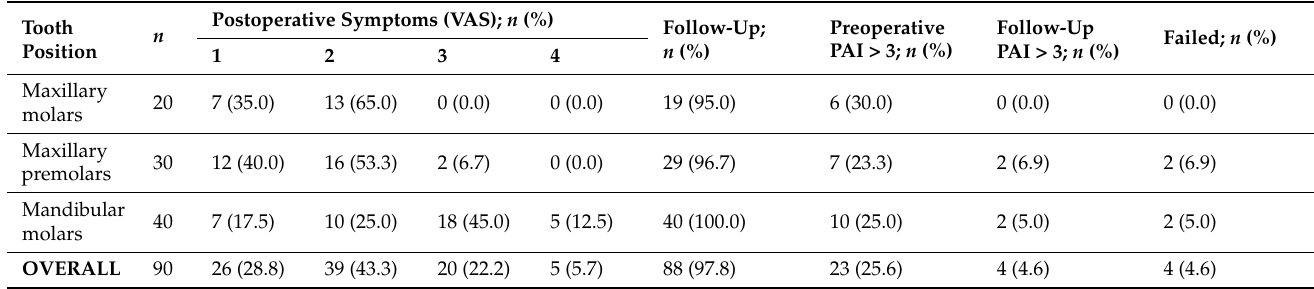
Table 4. Incidence of